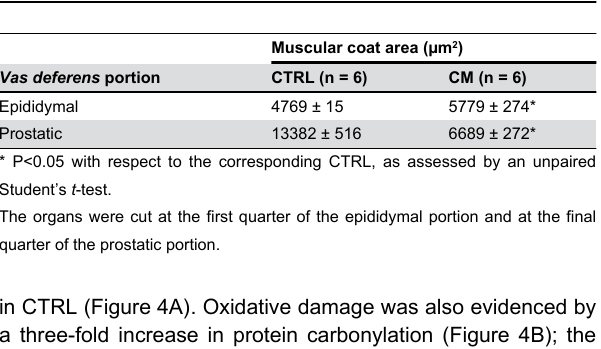
Table 2. Muscular coat area of the two portions of the vas deferens in CTRL male and CM rats, obtained from histomorphometric analysis of the images presented in Figure 3 (panels A, C, E and G).